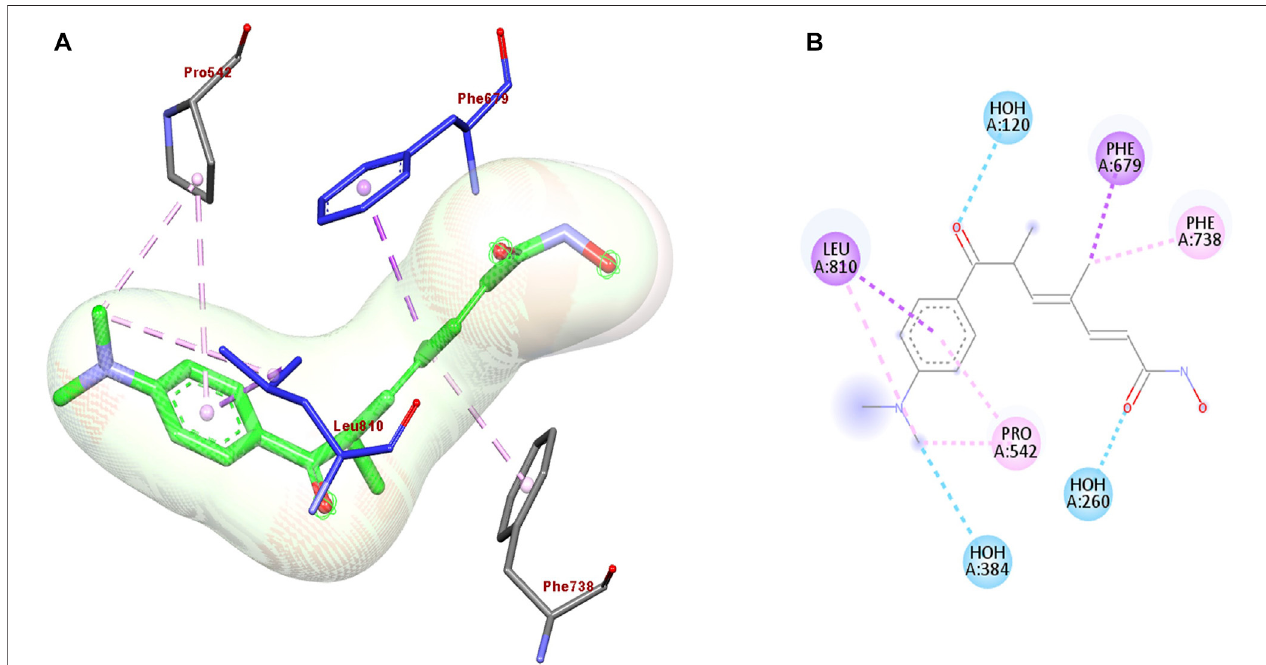
FIGURE 2 | (A) 3D and (B) 2D representation of the best re-docking pose of Trichostatin A (TSA) against HDAC7 (PDB code 3C10) receptor obtained using the Glide-SP